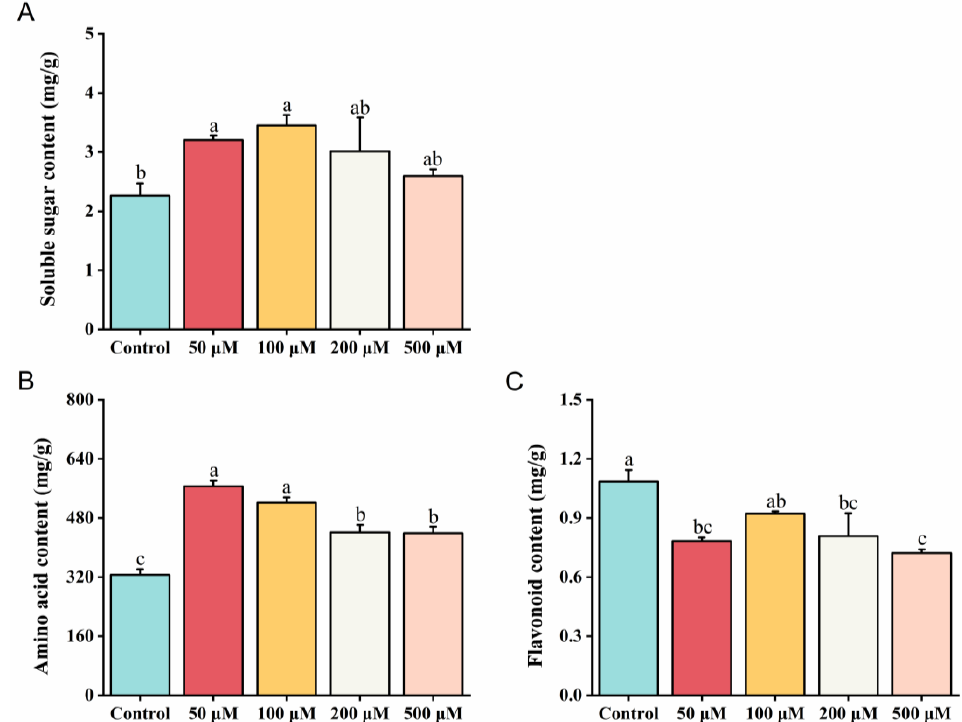
Figure 6. Effects of exogenous application of various concentrations of serotonin on the contents of soluble sugars ( A ), free amino acids ( B ) and flavonoids ( C ). Data are means + SE. Different letters represent significant differences among treatments (one-way ANOVA followed by LSD test).